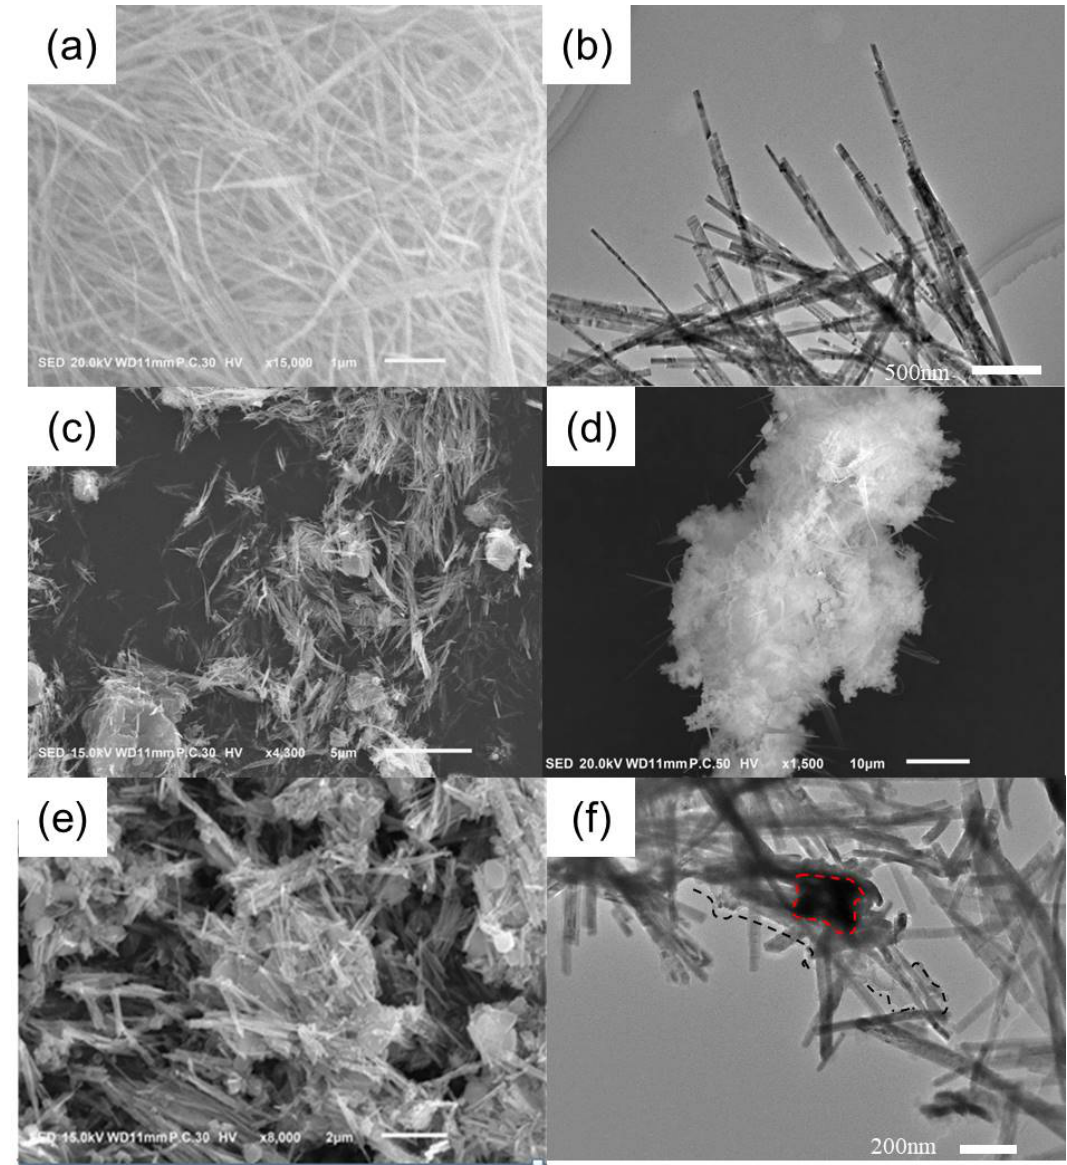
Figure 1. SEM of CdS NRs ( a ); CdS NRs-PANI ( c ) and CdS NRs-PANI-SiO 2 hydrogel ( d , e ); TEM of CdS NRs ( b ) and CdS NRs-PANI-SiO 2 hydrogel ( f